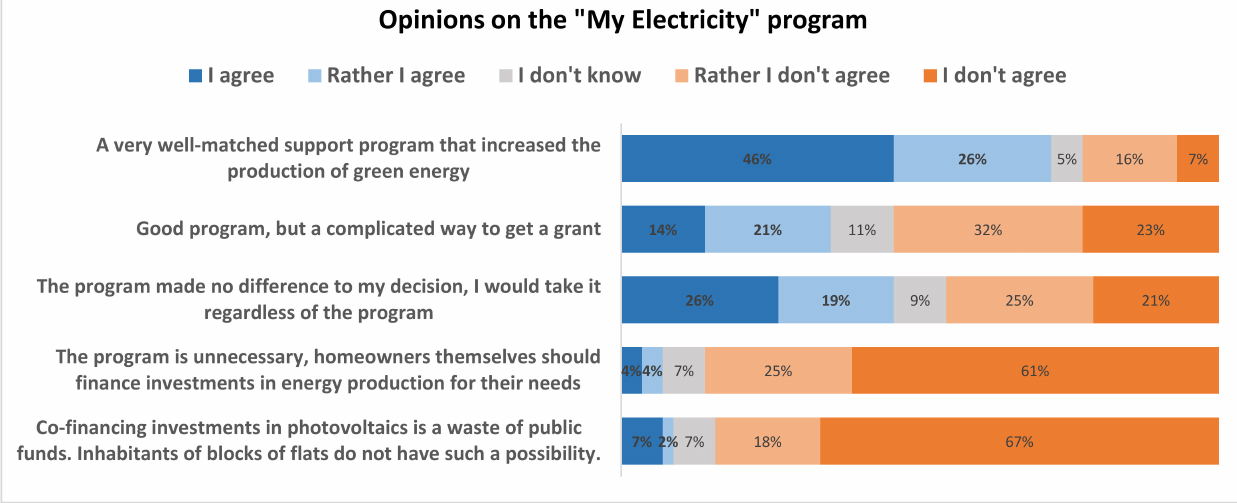
Figure 8. Viewpoints on the My Electricity program ( n = 57). Source: own